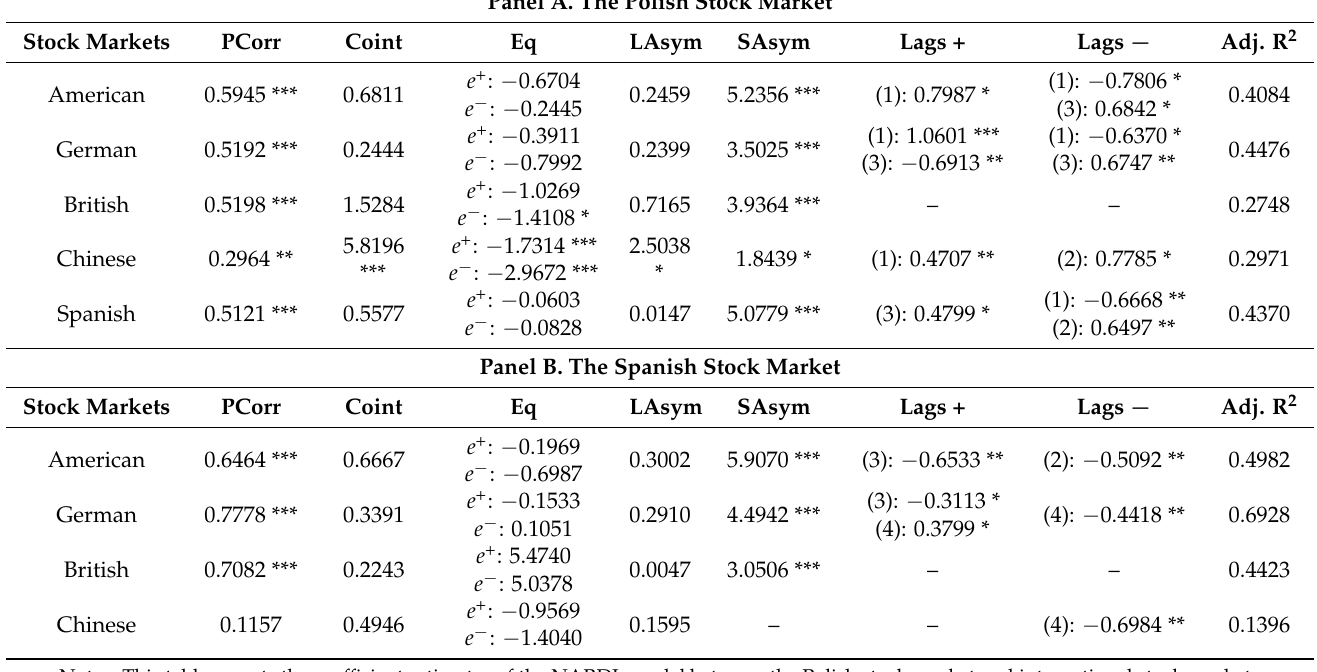
Table 5. Regression results of non-linear ARDL models: asymmetry and cointegration tests between the Polish (Panel A) and Spanish (Panel B) stock market and international (the American, German, British and Chinese) stock markets: first sub-period (January 1998–December